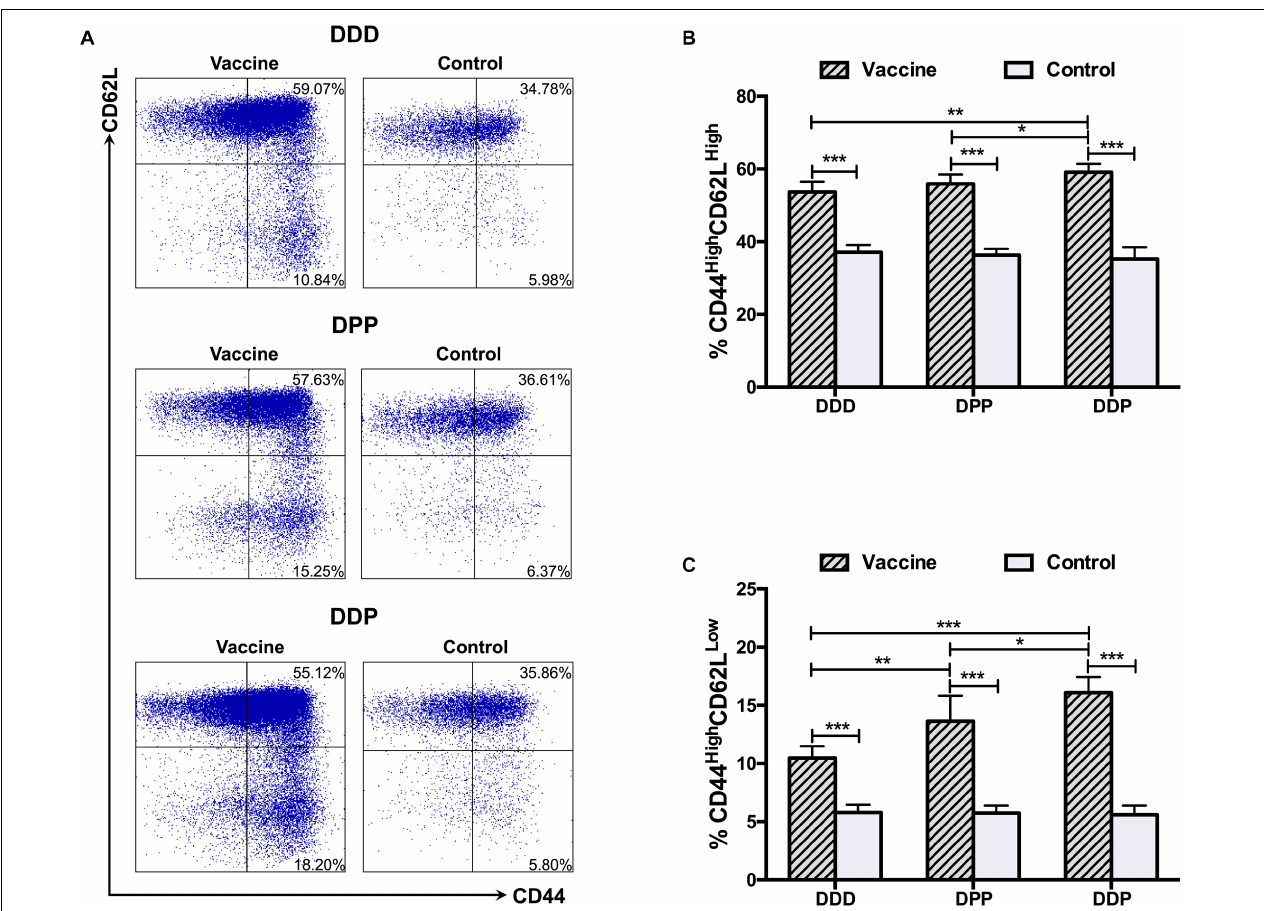
FIGURE 2 | CD8 + T cell responses against DENV2 elicited by different immunization regimens. (A) Representative expression of CD44 High T cells (gate on CD3 + CD8 + T cells). Quantification of the frequency of (B) CD44 High CD62L High and (C) CD44 High CD62L Low cells among CD8 + T cells. Data were expressed as mean + SD ( n = 8). ∗ P < 0.05, ∗∗ P < 0.01, ∗∗∗ P <